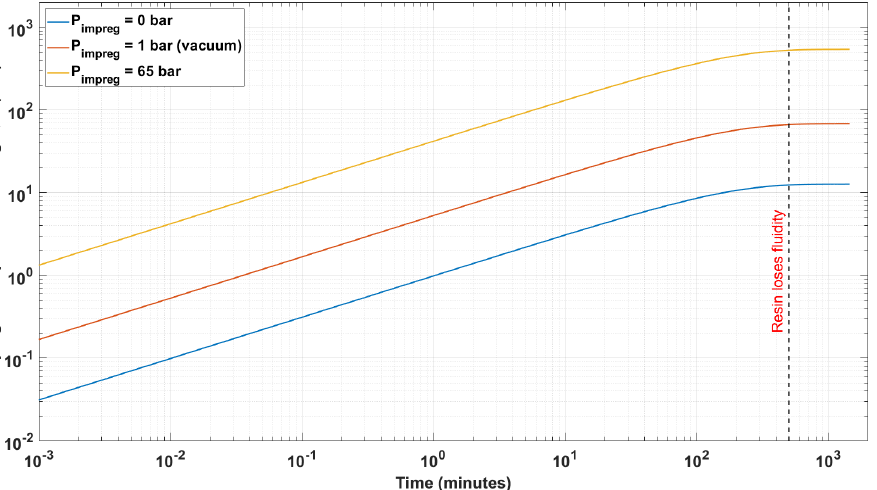
Figure 5. Visualization of Equation (5) for impregnating Indiana limestone with epoxy at three different pressures: P impreg = 0 bar (case I), P impreg = 1 bar (case II, vacuum), and P impreg = 65 bar (case III). In case I, the flow is driven only by capillary forces, while in cases II and III, P impreg consists of capillary pressure and applied overpressure. The advantage of pressure-assisted impregnation (case III) is an order of magnitude higher than that of the other